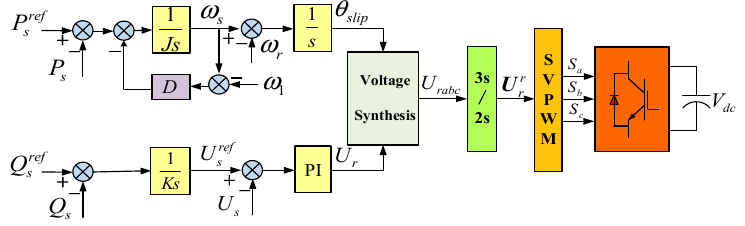
Figure 3. Virtual synchronous generator control of a doubly fed induction generator (DFIG).